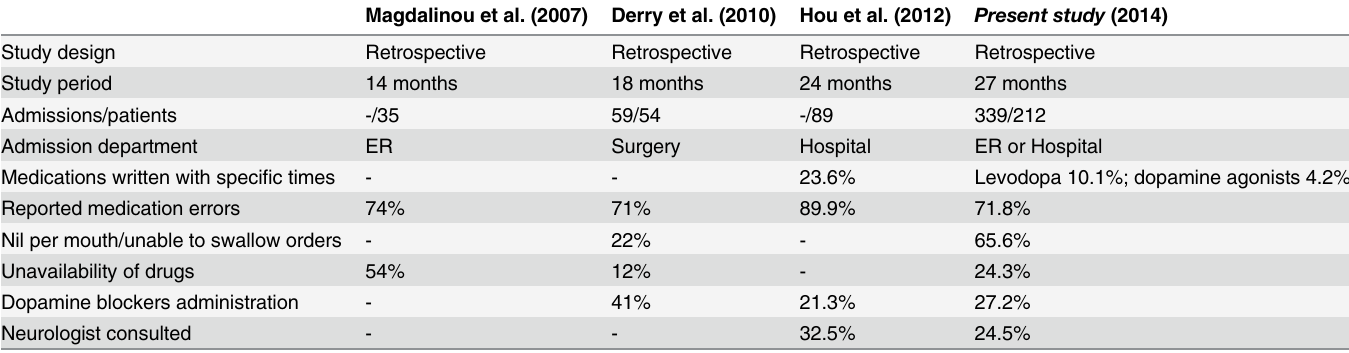
Table 2. Comparison of studies exploring medication management in the hospitalized Parkinson ’ s disease